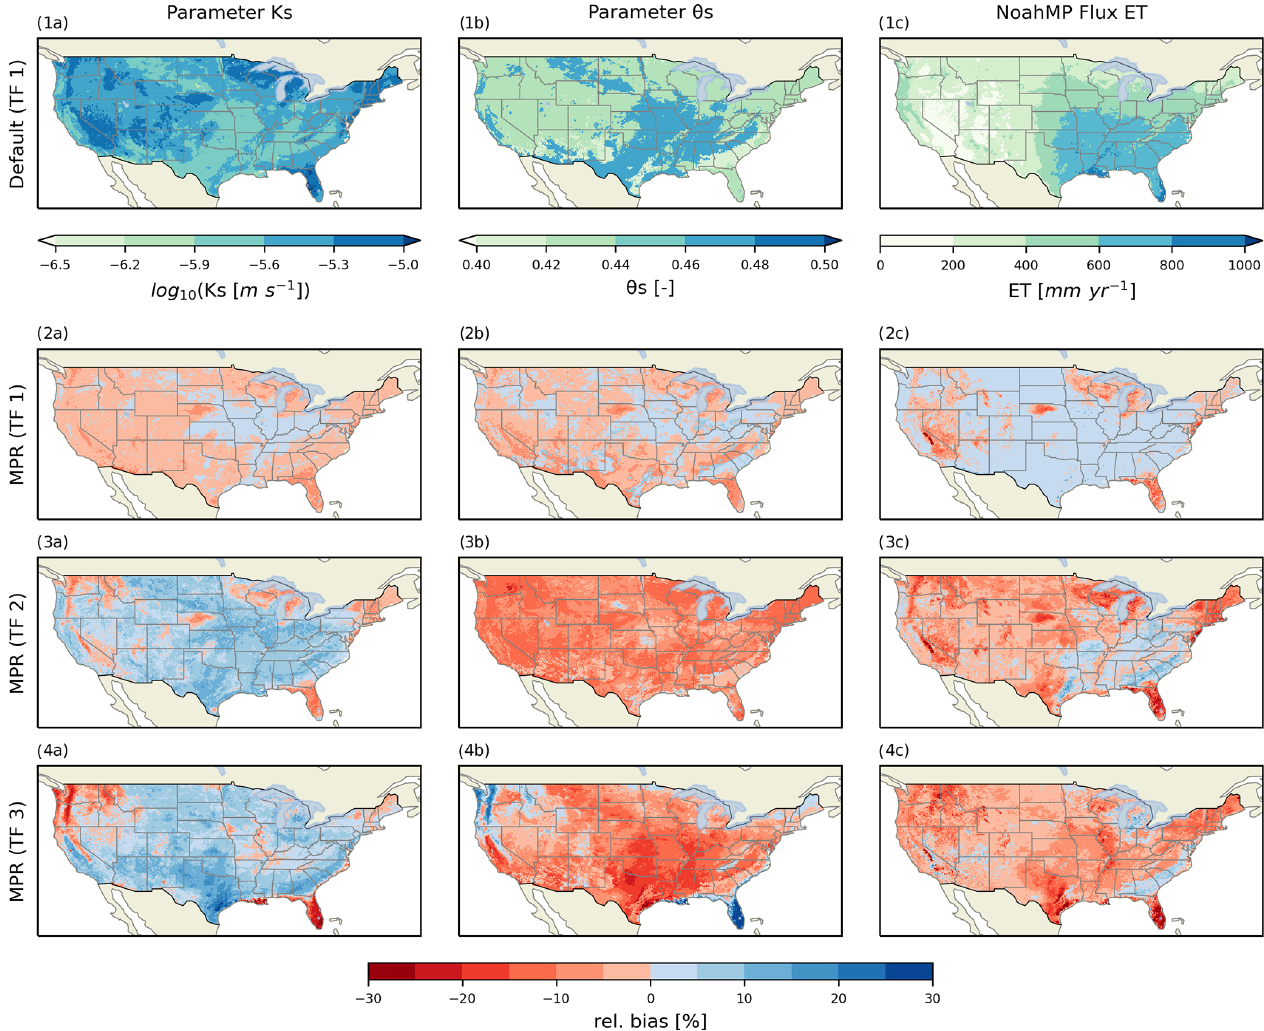
Figure 5. Grid plot showing maps of parameters and simulation results for Noah-MP. Columns denote the following parameters and variables: (a) soil parameter K s (saturated hydraulic conductivity) at the soil horizon between 0.1 and 0.3m, (b) soil parameter θ s (maximum soil moisture content) at the soil horizon between 0.1 and 0.3m, and (c) mean annual evapotranspiration values of Noah-MP. Rows denote the following configurations: row (1) shows the standard Noah-MP setup using the dominant USDA soil class based on SoilGrids (Hengl et al., 2017) and a lookup table based on the TF from (Cosby et al., 1984), and rows (2)–(4) show the relative differences ((MPR − default) / default) in percentage of parameters and simulation results using an MPR setup with a TF from Cosby et al. (1984), Saxton and Rawls (2006), and Vereecken et al. (1989, 1990),